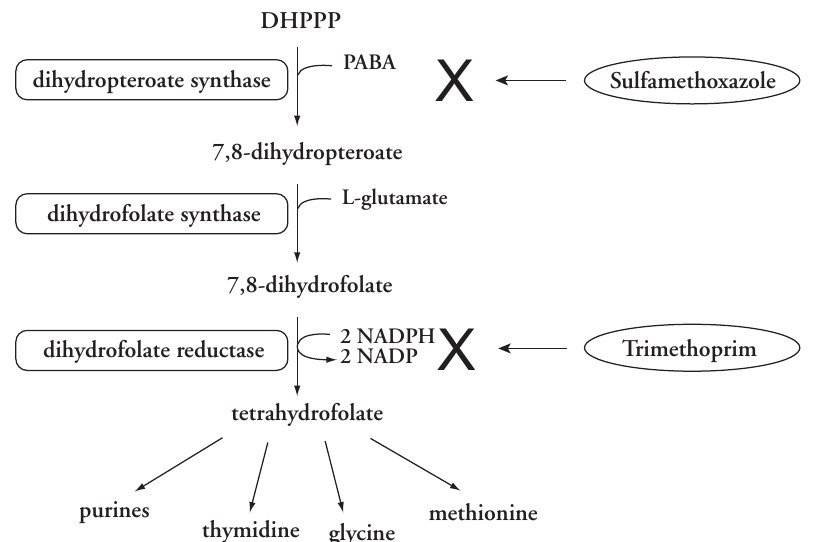
Fig. 1. – The folic acid synthesis pathway and TMP-SMZ action